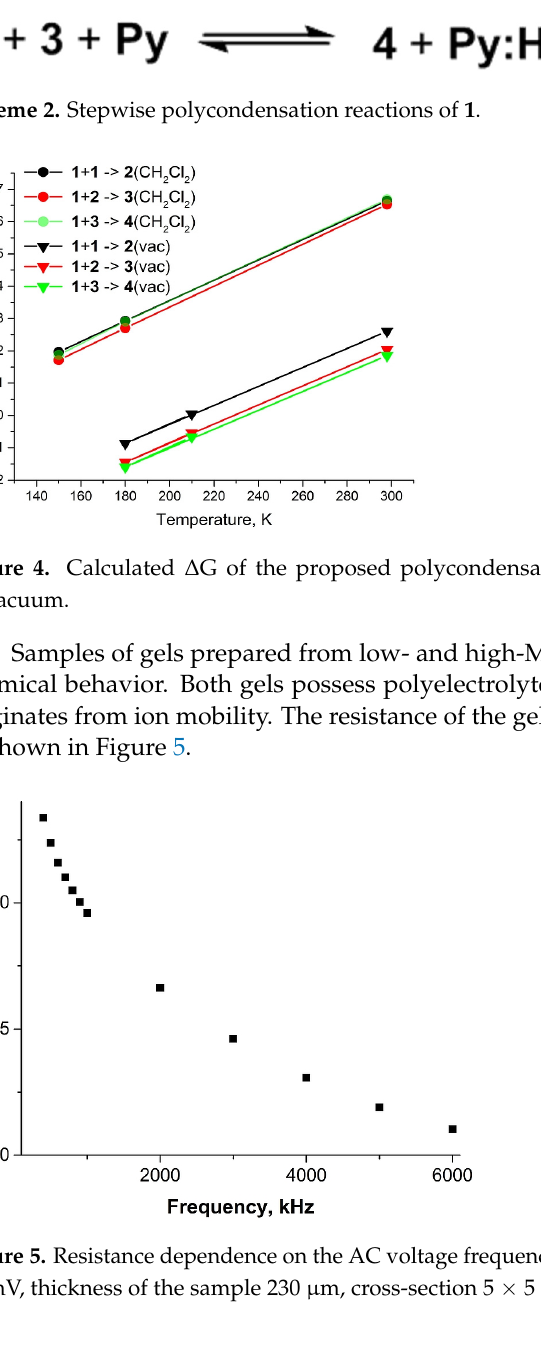
Figure 5. Resistance dependence on the AC voltage frequency of the low-MW gel. Voltage ampli- tude 35 mV, thickness of the sample 230 μ m, cross-section 5 × 5